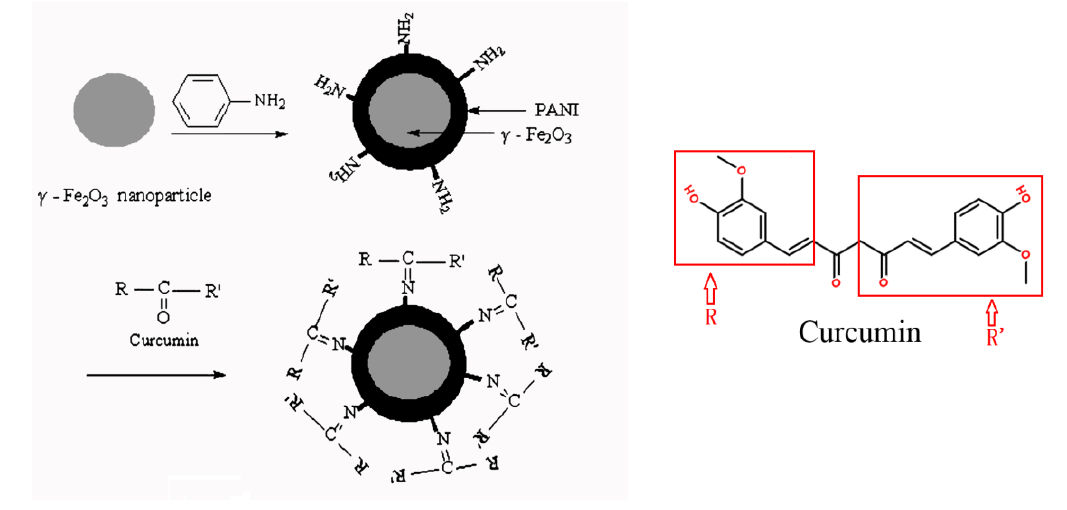
Figure 1. Schematic illustration for formation of γ-Fe 2 O 3